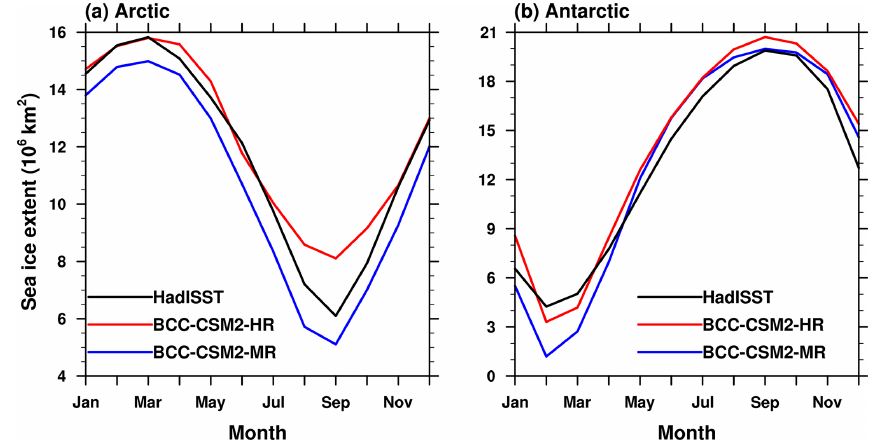
Figure 13. The mean (1995–2014) seasonal cycle of sea-ice extent (with a sea-ice concentration of at least 15%) in (a) the Northern Hemisphere and (b) the Southern Hemisphere for the observations from the Hadley Centre Sea Ice and Sea Surface Temperature dataset (black lines) and the simulations from BCC-CSM2-MR (blue lines) and BCC-CSM2-HR (red